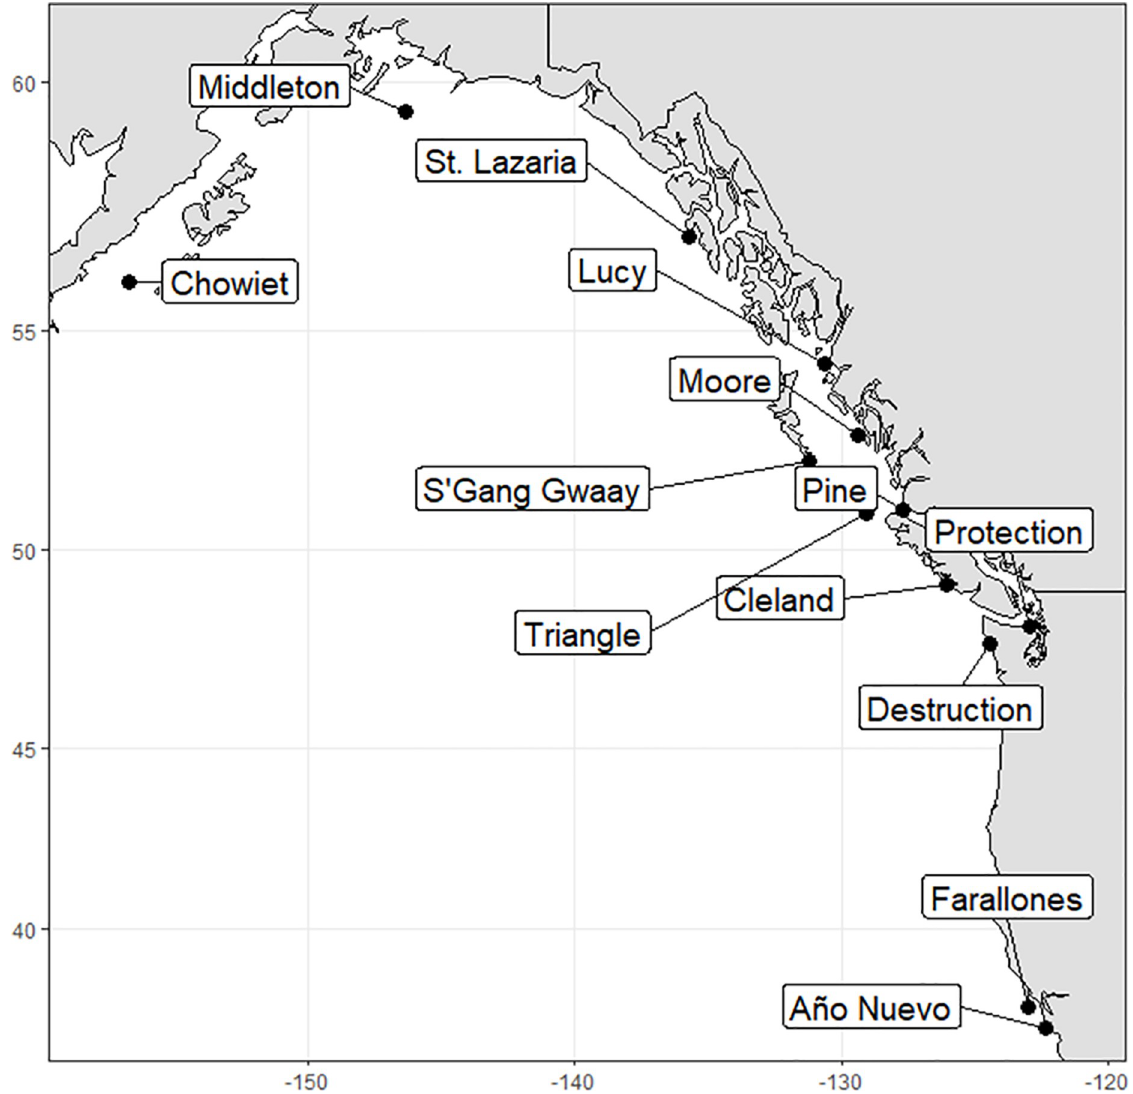
Fig 1. Locations of rhinoceros auklet breeding colonies along the Pacific Coast of North America where samples were collected for genetics analysis and light-level geolocator tags were